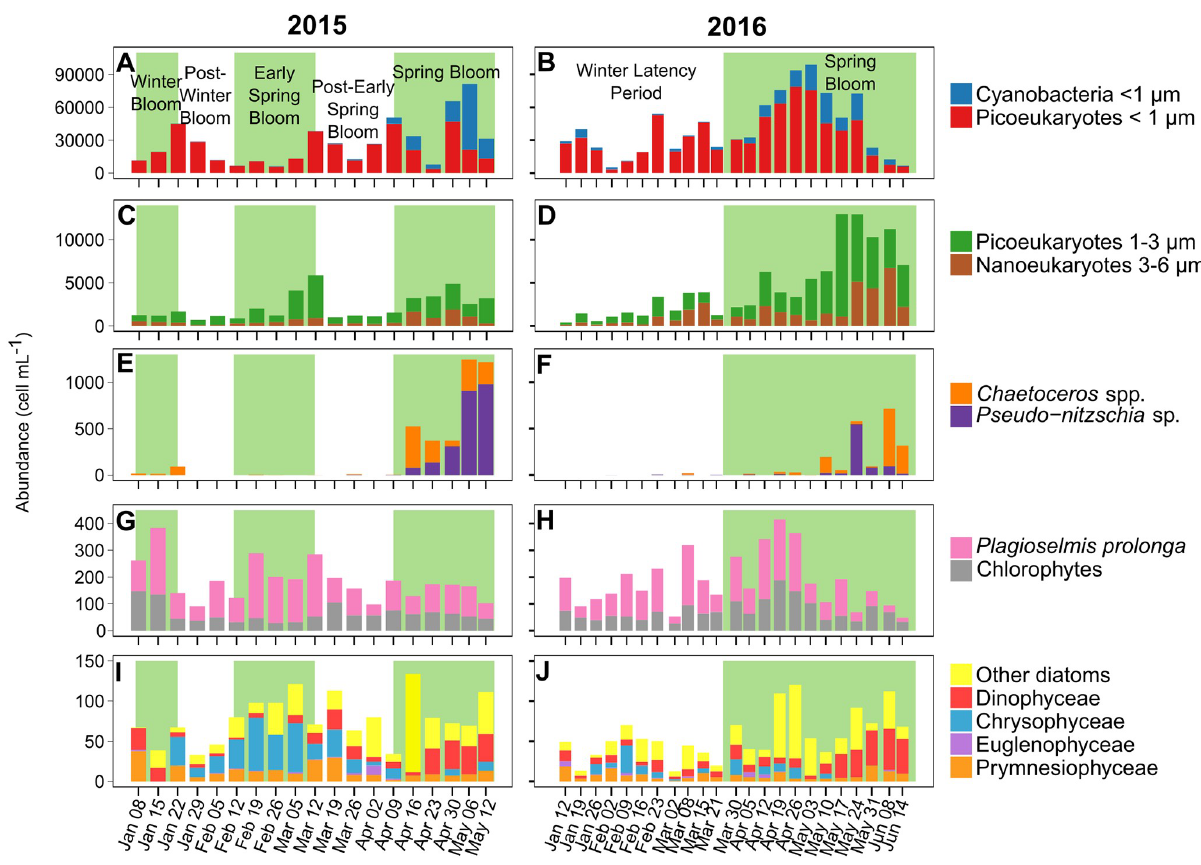
Fig 6. Phytoplankton abundances and diversity. Analyzed by flow cytometry for 2015 (A and C) and 2016 (B and D). Dominant taxa observed by microscopy for 2015 (E, G and I) and 2016 (F, H and J). The background colors for the various periods are the same as in Fig